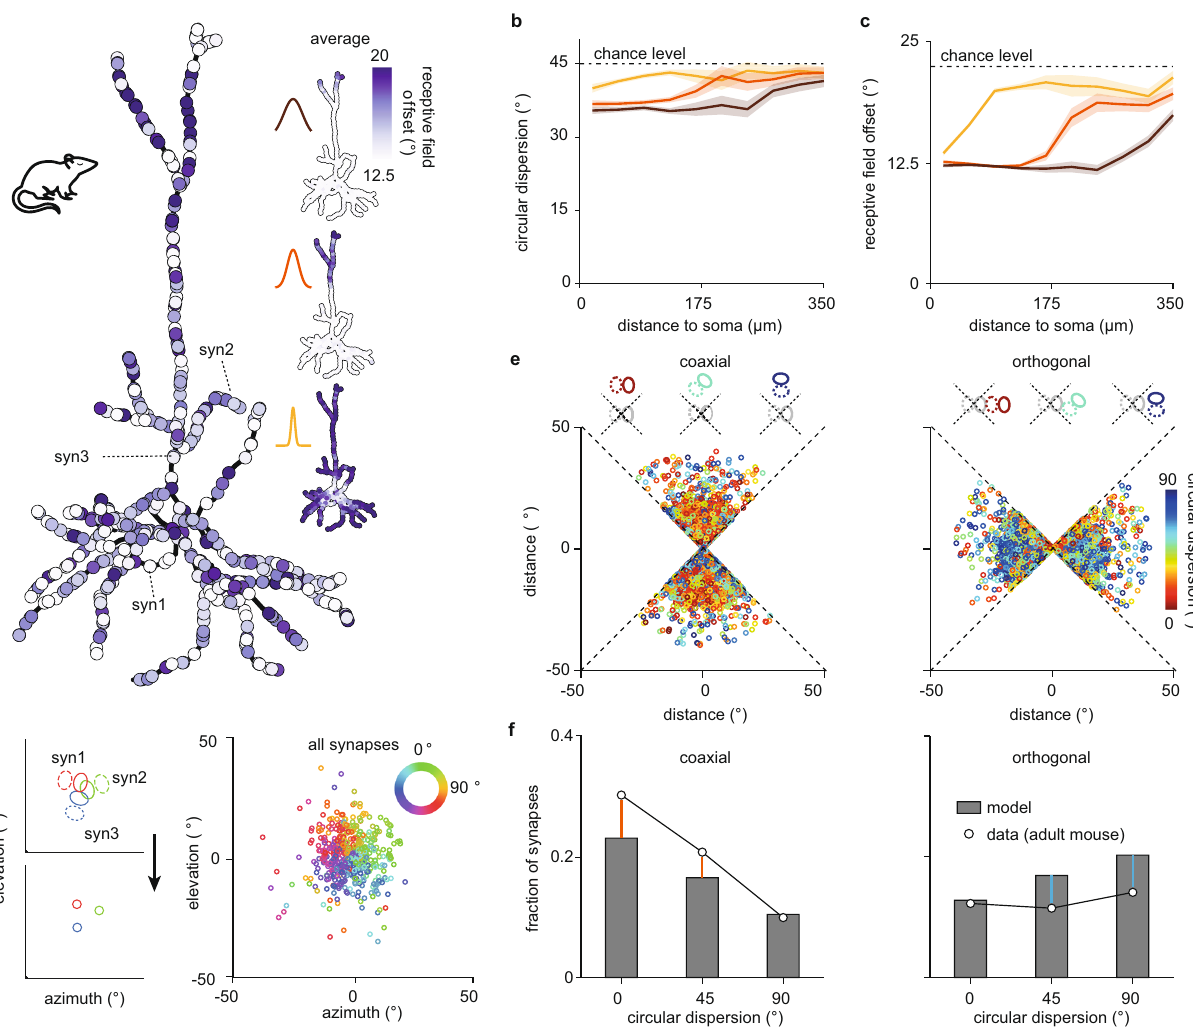
Fig. 6 Backpropagating action potentials establish a dendritic map of visual space in a model of the mouse visual cortex. a Receptive fi eld offset on the reconstructed pyramidal cell with synapses with a large receptive fi eld center spread corresponding to mouse. Color of synapses indicates the receptive fi eld offset of the associated receptive fi eld. Inset shows the receptive fi eld offset averaged over 80 simulations for the three different attenuation factors (25, 75, and 125 μ m) in Fig. 5b. b , c Circular dispersion ( b ) and receptive fi eld offset ( c ) for the three different bAP attenuation factors in Fig. 5b and as a function of path distance from the soma. Shaded areas indicate 95% con fi dence interval around the mean. d (Left) Illustration of three synaptic receptive fi elds (see a ) in visual space (top) and the same receptive fi elds represented as circles with color denoting orientation preference (bottom). (Right) All synaptic receptive fi elds from one simulation. e Receptive fi eld centers in coaxial (left) and orthogonal (right) visual space colored according to their circular dispersion averaged over 80 simulations. Preferred orientation of the soma is vertical. f Histogram of circular dispersions between synaptic and somatic receptive fi elds in coaxial (left) and orthogonal (right) visual space in the model and experiments (data from adult mouse visual cortex reproduced from ref. 8 ). Preferred orientation of the soma in each schematic is always vertical, as indicated by a gray somatic receptive fi eld in the center, while the preferred orientation of a synapse varies, as indicated by a colored receptive fi eld either in coaxial or orthogonal space (see e